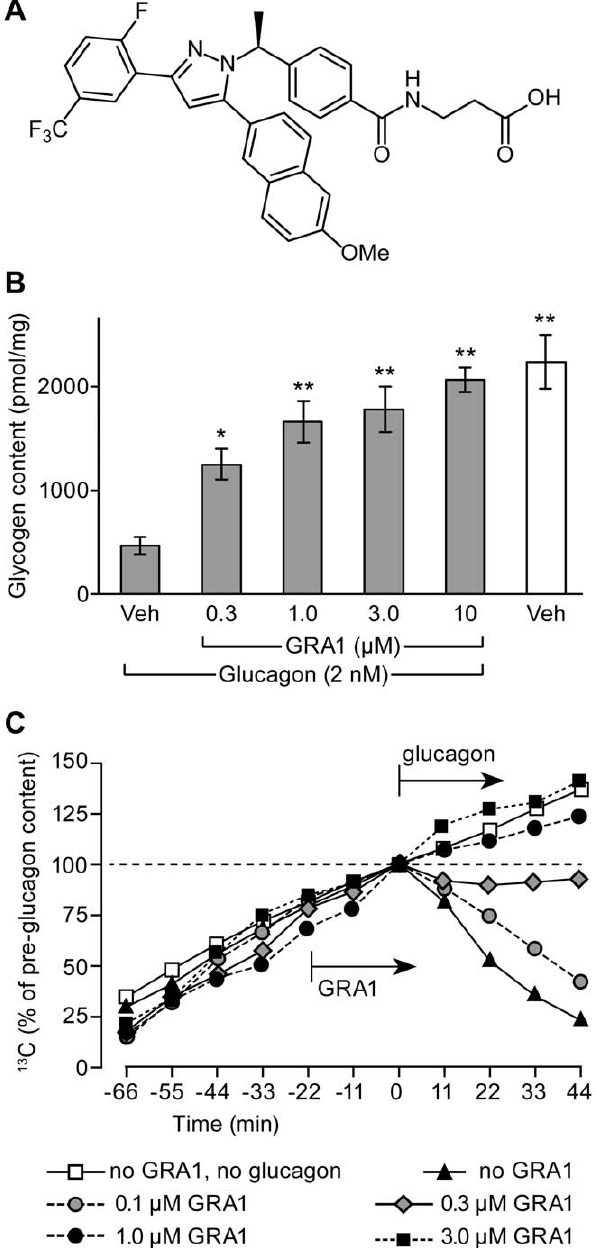
Figure 1. GRA1 inhibits glucagon-mediated glycogenolysis in vitro and ex-vivo . (A) The chemical structure of GRA1. (B) Dose- dependent inhibition of glucagon-stimulated glycogenolysis in human hepatocytes. The cells were pretreated for 3 h with 200 nM insulin and then challenged with 2 nM glucagon with vehicle (Veh, medium with 1% DMSO) or 0.3–10 m M GRA1. Glycogen content was measured after incubating for 1 h. *p , 0.05 and **p , 0.01 vs. glucagon + vehicle alone. (C) Inhibition of glucagon-stimulated glycogenolysis in perfused liver prepared from the hGCGR mouse. Livers were perfused with Ringers solution containing 6.7 mM [2- 13 C]pyruvate while 13 C content (indica- tive of accumulated [ 13 C]glycogen) was monitored dynamically by nuclear magnetic resonance imaging. At time= 2 22 min, 0.1–3.0 uM GRA1 or vehicle was added to the perfusate; 50 pM glucagon or vehicle was added at time 0. The data are means 6